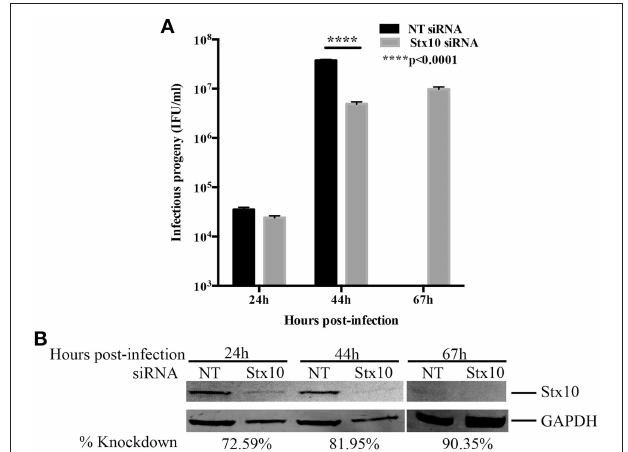
FIGURE 2 | Effect of siRNA knockdown of syntaxin 10 on inclusion development and chlamydial infectious progeny. (A) Syntaxin 10 (Stx10) or NT (non-targeting, control) siRNA-treated HeLa cells were infected at an MOI of 0.5 with C. trachomatis serovar L2 for 24, 44, or 67h. Monolayers were lysed in dH 2 O, then serial dilutions were replated onto a fresh monolayer of cells. These cells were fixed and processed to enumerate inclusions. Inclusions were counted using a 20X objective and values are expressed as mean and standard error of the mean and then analyzed with an ordinary One-Way ANOVA with a Tukey’s multiple comparison test in GraphPad Prism 6 software. Data are representative of 3 independent experiments. (B) Corresponding Western blot of cell lysates harvested at the time points described above to test for efficient knockdown of syntaxin 10 (stx10) compared to loading control